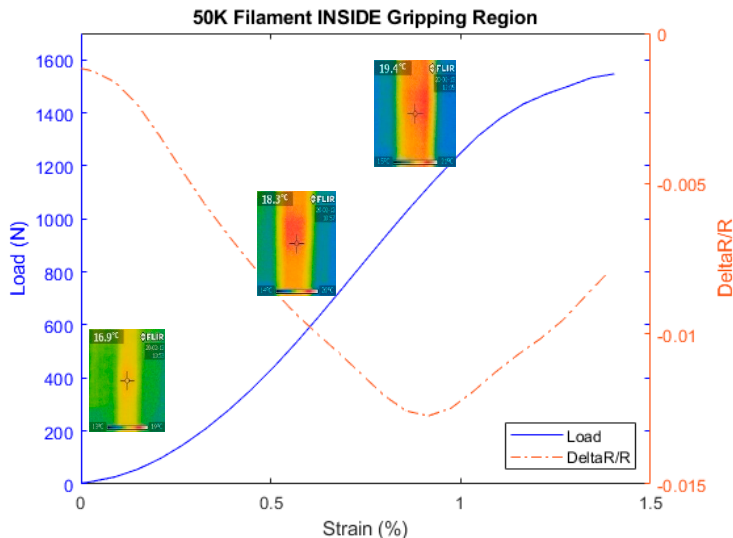
Figure 19. Load and relative resistance variation for the 50 K carbon fiber.